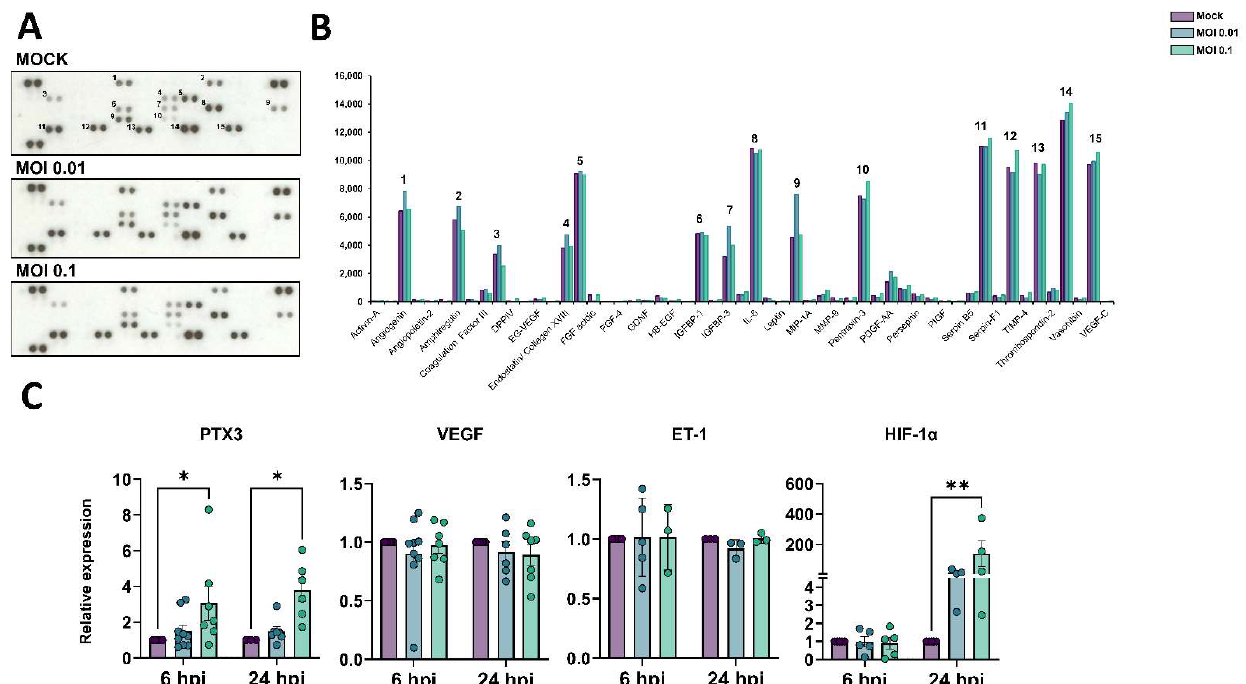
Figure 4. Production of angiogenic-related molecules is modulated by SARS-CoV-2 in HBMECs. ( A ) Conditioned medium from Mock and SARS-CoV-2-exposed HBMEC cultures (both with MOI 0.01 and 0.1) were analyzed via Proteome Profiler Human Angiogenic Antibody Array and detected by chemoluminescence, each protein detected in duplicated spots. ( B ) Densitometric analysis of membranes in ( A ) revealed the analytes with the strongest signal and which were affected by the SARS-CoV-2 challenge. Spots labelled 1-15 in A correspond to the analytes depicted in B . ( C ) RT-qPCR analysis of angiogenesis-related genes in HBMECs revealed that PTX3 and HIF-1α were increased